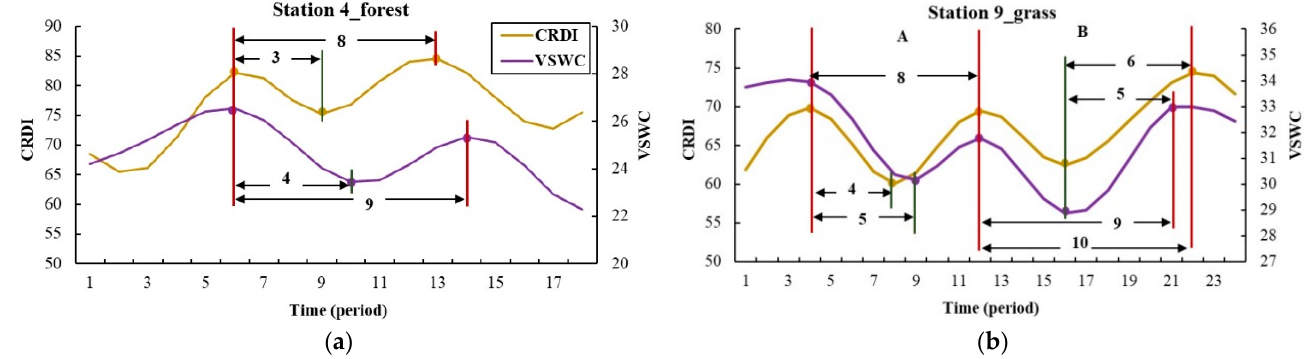
Figure 12. The difference of time-lag between peak and valley. Station 4 was selected as the station of the forest. The 10th and the 30th periods of the VSWC index of 2016 are the first and last points, and the 13rd and the 33rd periods of CRDI of 2016 are the first and last points ( a ). Station 9 was selected as the station of grass. The 10th and the 33rd periods of the VSWC index of 2016 are the first and last points; and the 14th and the 37th periods of CRDI of 2016 are the first and last points ( b ).